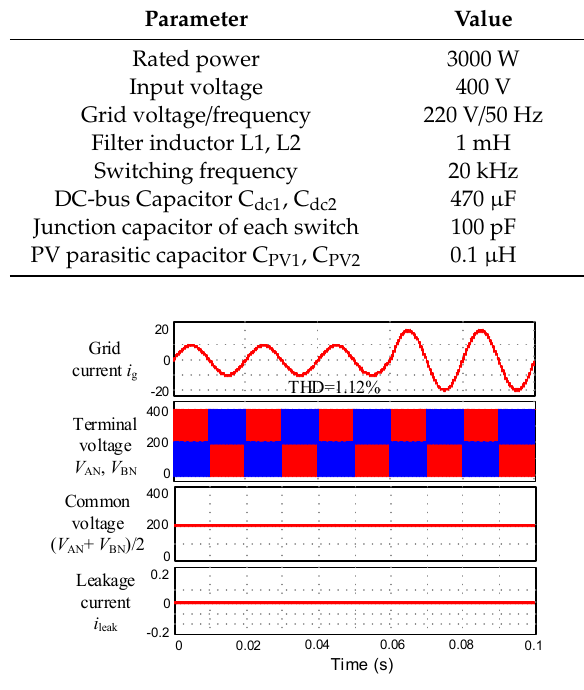
Figure 30. Waveforms of grid current, terminal voltage, CM voltage, and leakage current in the case.